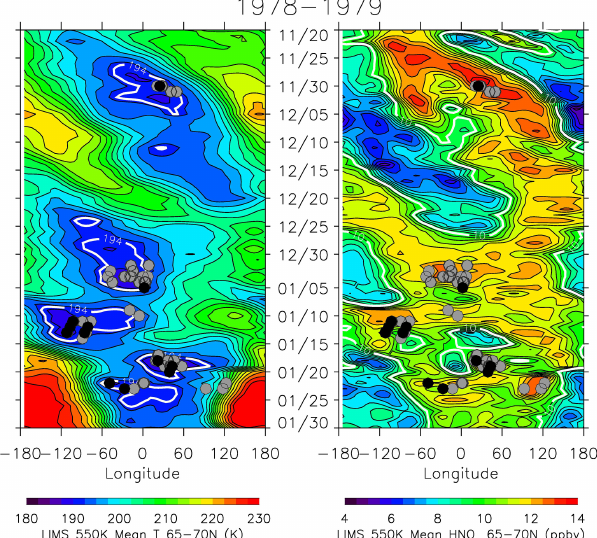
Figure 10. Hovmöller diagram (time vs. longitude) of the effects of PSCs from LIMS V6 (gray circles) and from SAM II (black cir- cles) for 20 November 1978 to 30 January 1979. (left) Locations of PSC sightings are over plotted on fields of daily mean temperature between 65 and 70 ◦ N; contour interval is 2.5K and the white con- tour is 194K. (right) The fields are of daily mean HNO 3 ; contour interval is 0.5ppbv and white contour is 10ppbv.